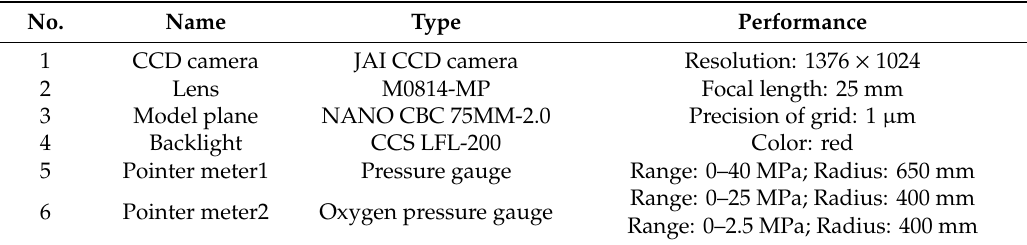
Table 1. Main experimental devices.